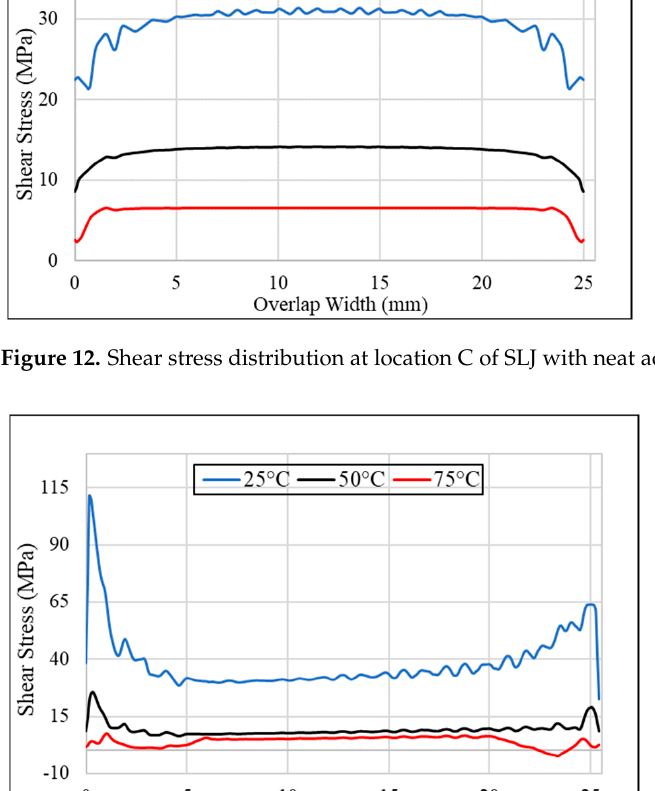
Table 3. Comparison of Percentage Change in Peel Stress and Shear Stress with the Inclusion of 1.5